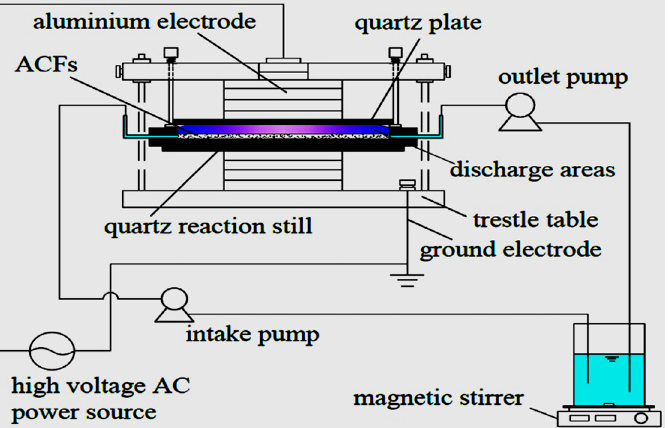
Figure 8. Reactor experimental set up utilised for the degradation of triclosan (TCS) [163].